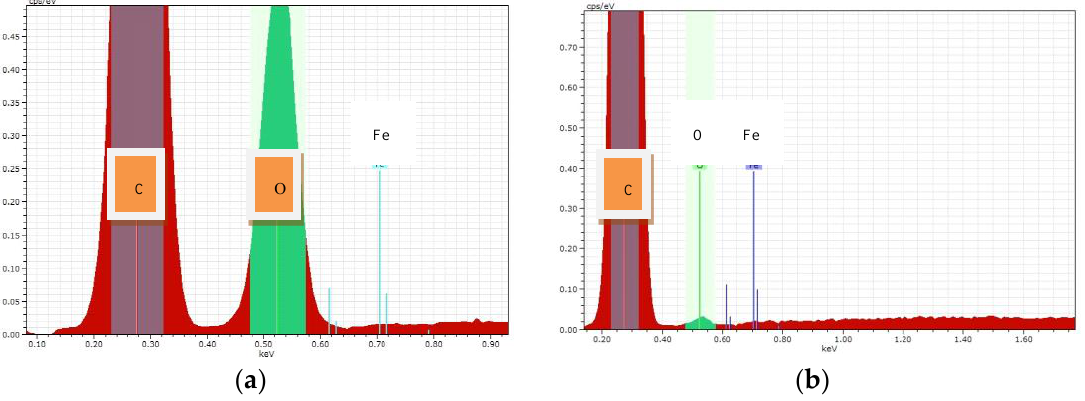
Figure 2. Elemental analysis of composites with the embedded (Fe 0 ) metal, obtained using methods of: ( a )—ion implantation; ( b )—SHF-irradiation. of: ( a )—ion implantation; ( b )—SHF-irradiation.